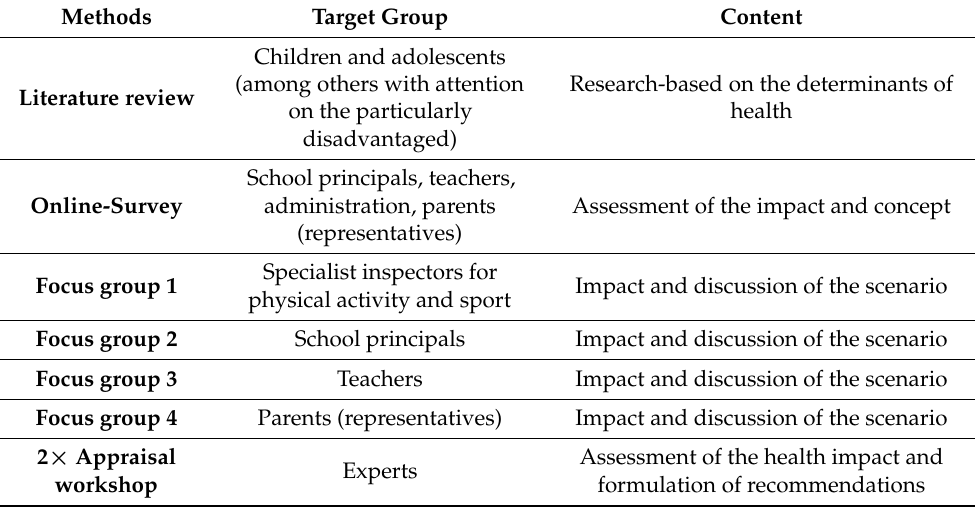
Table 1. Methods for assessing potential health